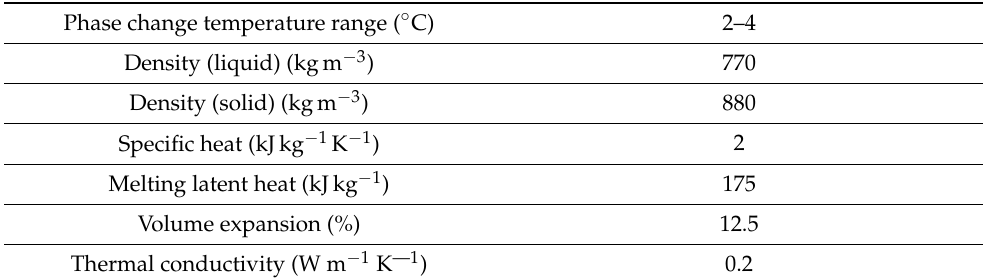
Table 2. Properties of the